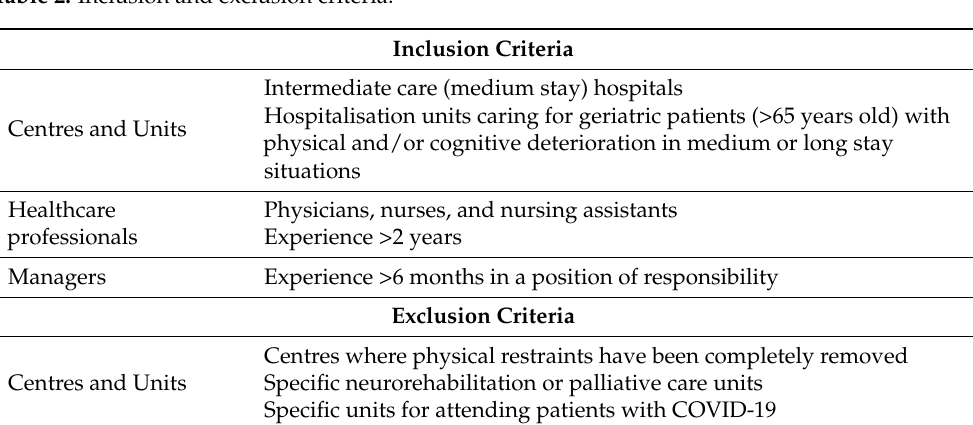
Table 2. Inclusion and exclusion